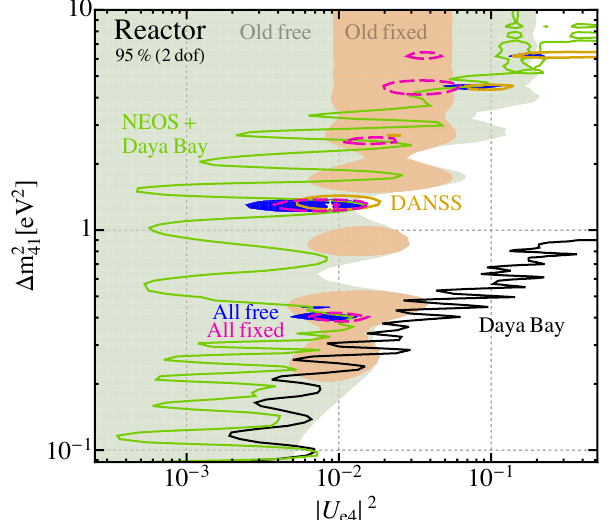
Figure 2 . Allowed regions at 95% CL (2 dof) from reactor data. The solid curves correspond to Daya Bay spectral data (black), NEOS + Daya Bay (green), and DANSS (orange); they are independent of assumptions on (cid:13)uxes because they are only based on spectral ratios. The light- shaded areas labelled \old" correspond to all data from table 1 except Daya Bay, DANSS, NEOS, and they are shown for the (cid:13)ux-free analysis making no assumptions about (cid:13)ux normalization and spectra (light green), as well as for the (cid:13)ux-(cid:12)xed analysis (light orange), assuming reactor (cid:13)ux predictions and their published uncertainties. The blue shaded regions correspond to all reactor data from table 1 for the (cid:13)ux-free analysis, whereas the dashed magenta contours indicate the global data for the (cid:13)ux (cid:12)xed analysis. The white (pink) star indicates the best (cid:12)t point (cid:1) m 2 = 1 : 29 eV 2 , 41 sin 2 (cid:18) 14 = 0 : 0089 ((cid:1) m 2 = 1 : 29 eV 2 , sin 2 (cid:18) 14 = 0 : 0096) for free ((cid:12)xed) reactor 41